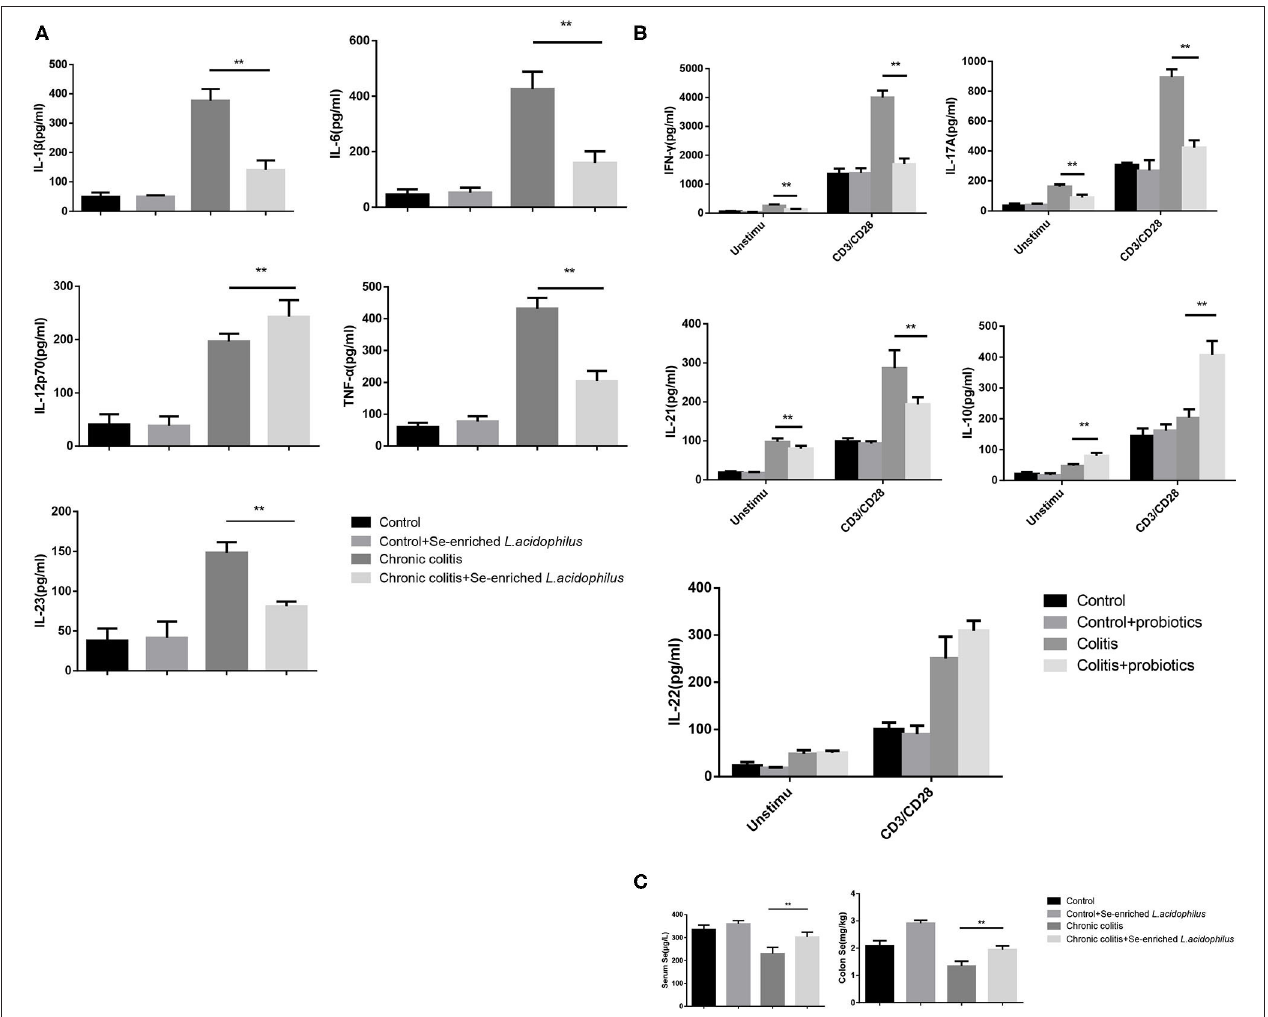
FIGURE 2 | Cytokine concentrations produced by LPL cells and Se concentrations in serum and colon tissue. (A) Unstimulated cells; (B) LPL cells with or without anti-CD3 and anti-CD28 mAbs; (C) Se concentrations in serum and colon tissue. The values are expressed as the mean ± standard error. (** P < 0.01) ( n = 5).